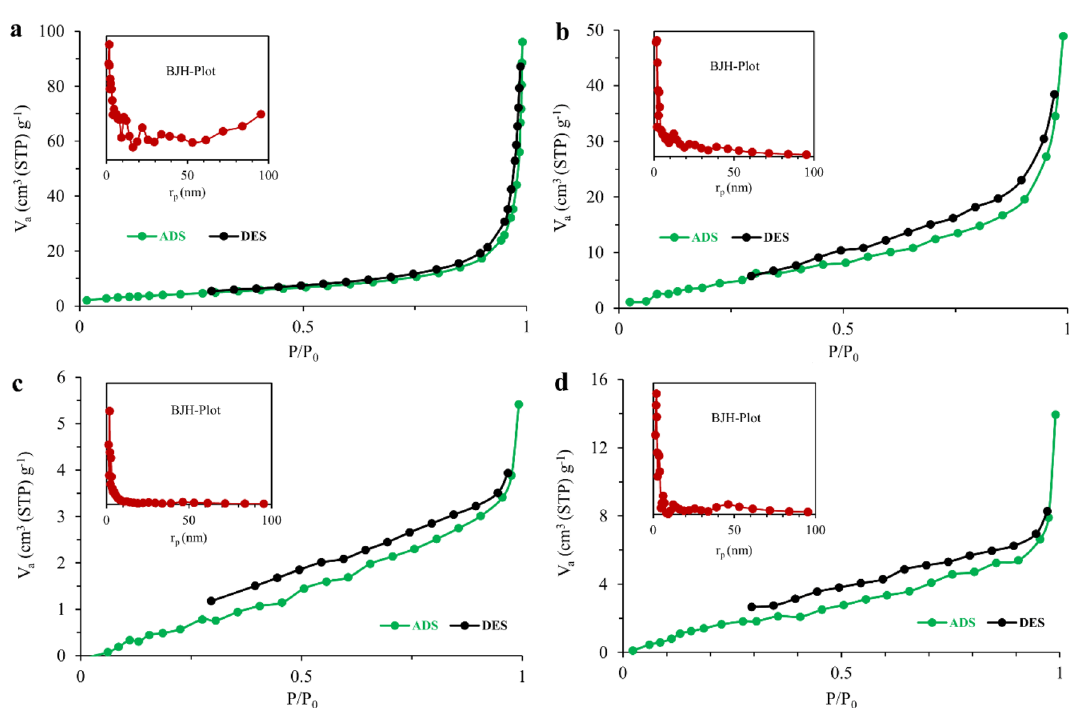
Figure 4. The SEM images of the prepared LDH ( a ), LDH-ITA ( b ), pure gellan gum ( c ), NC-1% ( d and e ), and the transmission electron micrograph of NC-1% ( f ).